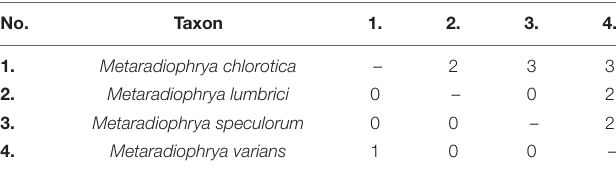
TABLE 4 | Numbers of CBCs (below diagonal) and hemi-CBCs (above diagonal) between ITS2 molecules of four Metaradiophrya species isolated from lumbricid